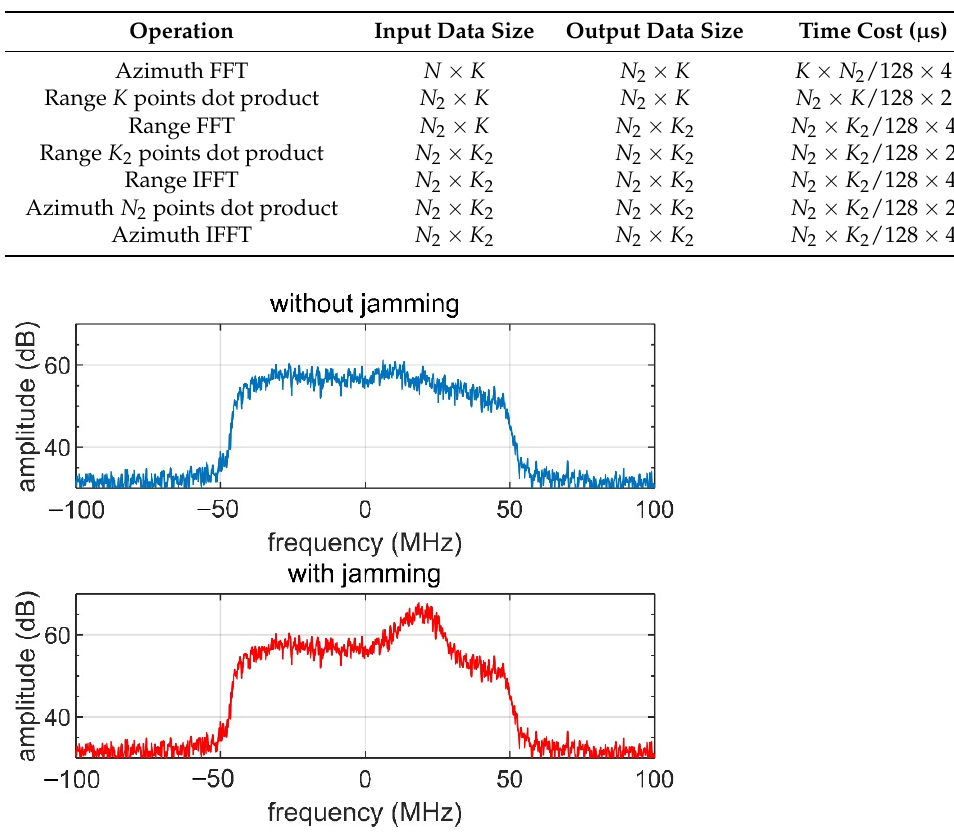
Table 1. The major time cost of the CS algorithm.